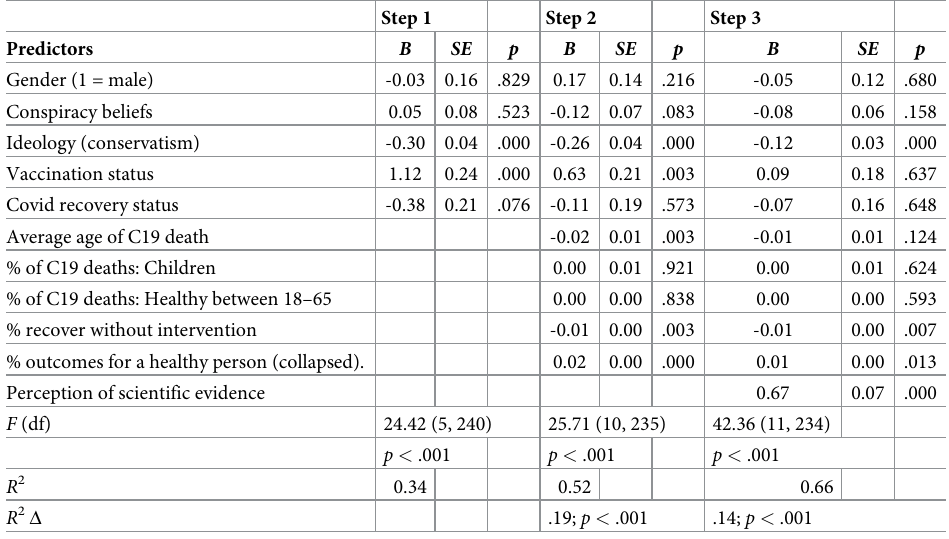
Table 13. Predicting NNP support with core indicators and controls (Sample